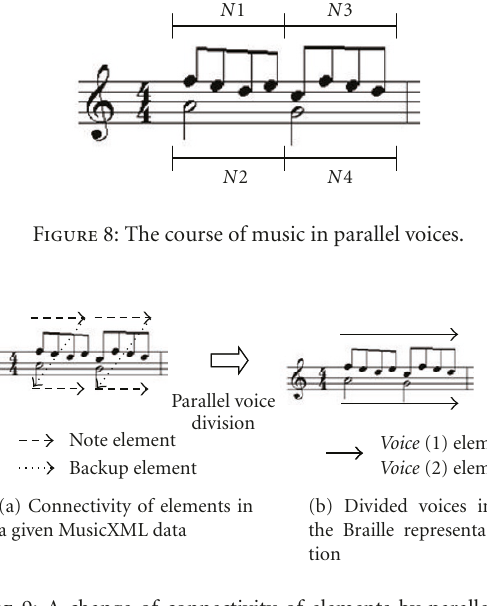
Figure 9: A change of connectivity of elements by parallel voice